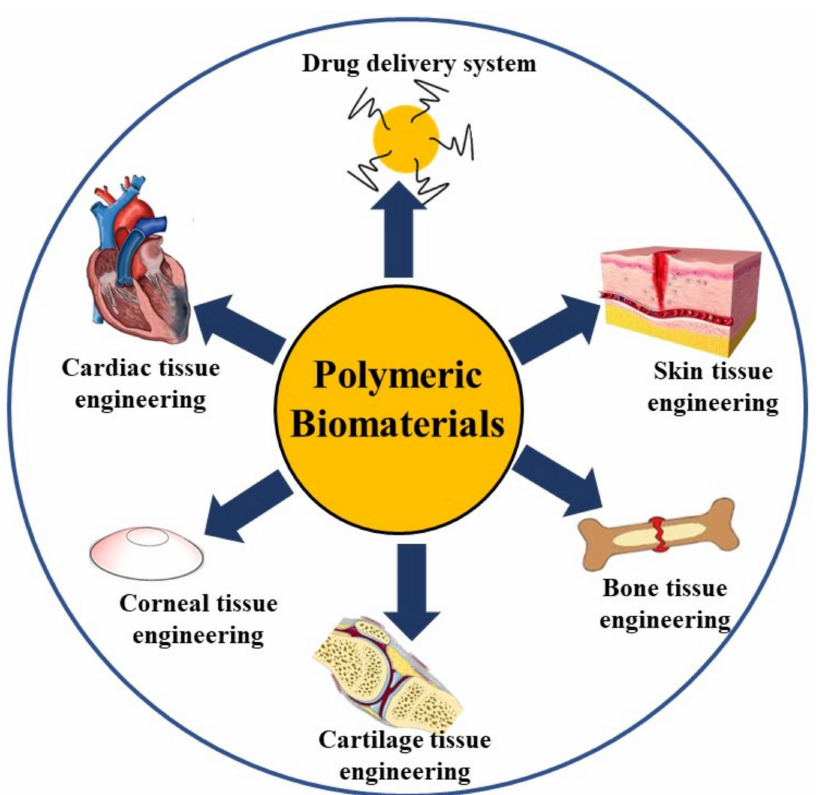
Scheme 1. Schematic illustrating the applications of polymeric biomaterials in different biomedical